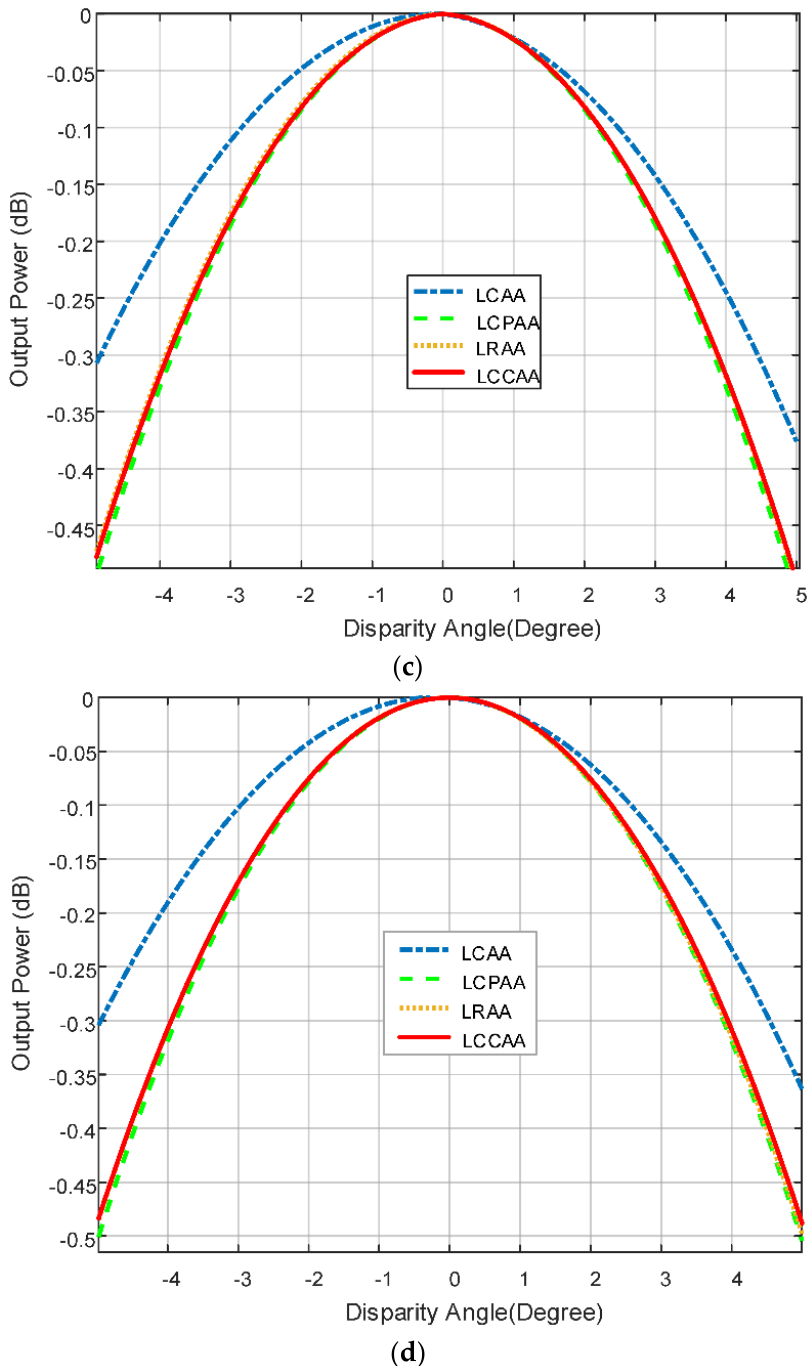
Figure 4. ( a ) Power pattern comparison of all structures based on the FDL technique with respect to the disparity angle. ( b ) Power pattern comparison of all structures based on the ODL technique with respect to the disparity angle. ( c ) Power pattern comparison of all structures based on the VDL technique with respect to the disparity angle. ( d ) Power pattern comparison of all of the structures based on the NVL technique with respect to the disparity